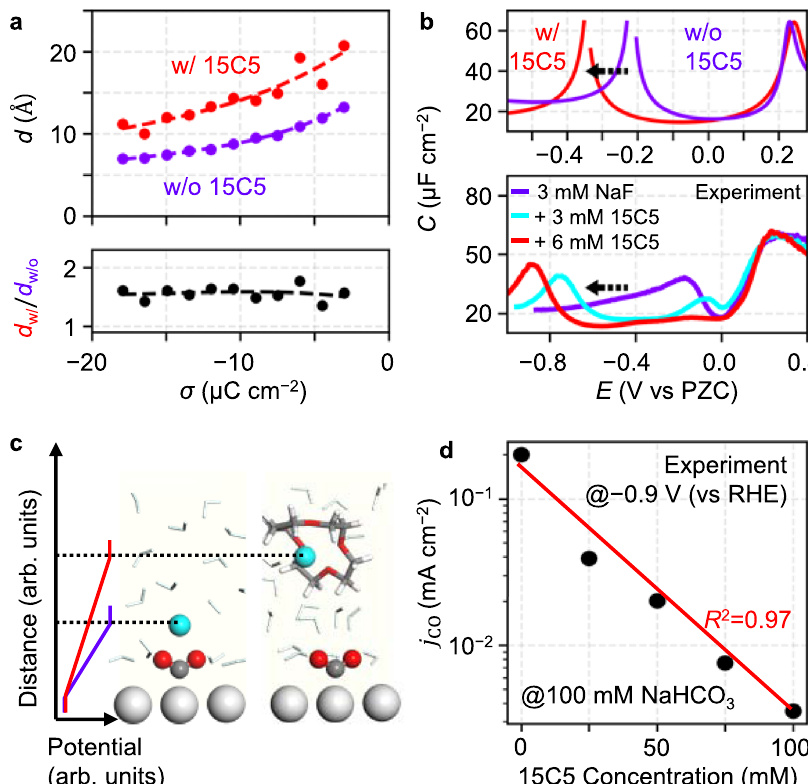
Fig. 4 Structural change of EDL to modulate interfacial fi eld strength and CO 2 RR activity. a Simulation-calculated charge-separation distance, d , is plotted as a function of the surface charge density, σ . The d when Na + is complexed with 15C5 ( d w/ ) is approximately two times larger than the d when Na + is uncomplexed ( d w/o ). b A cathodic hump of differential capacitance, C , when Na + is complexed with (w/) 15C5 shifts to a more negative potential than when Na + is uncomplexed (w/o) in our simulation (upper panel), and experiments corroborate the negative-potential shift of the cathodic hump following the crown ether complexation (lower panel). c DFT-CES snapshots showing that uncomplexed Na + develops a more direct interaction with the adsorbed CO 2 than 15C5- complexed Na + , forming a compact EDL structure with a stronger fi eld. Also, the uncomplexed Na + can easily make a direct coordination to the adsorbed CO 2 . d A logarithmic dependence of CO partial current density, j CO , on the 15C5 concentration that is experimentally measured for the Ag(111) electrode at − 0.9